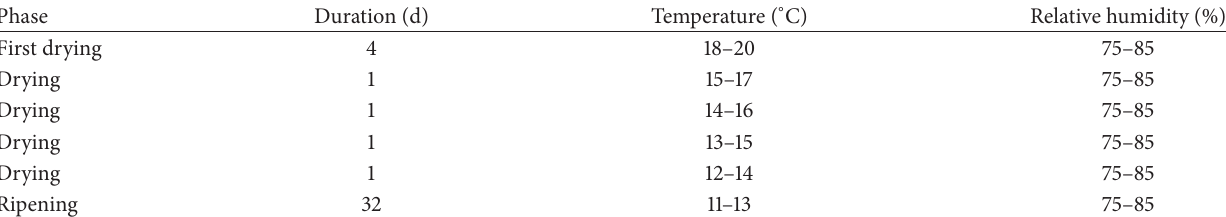
Table 2: Phases and thermohygrometric parameters applied during salami